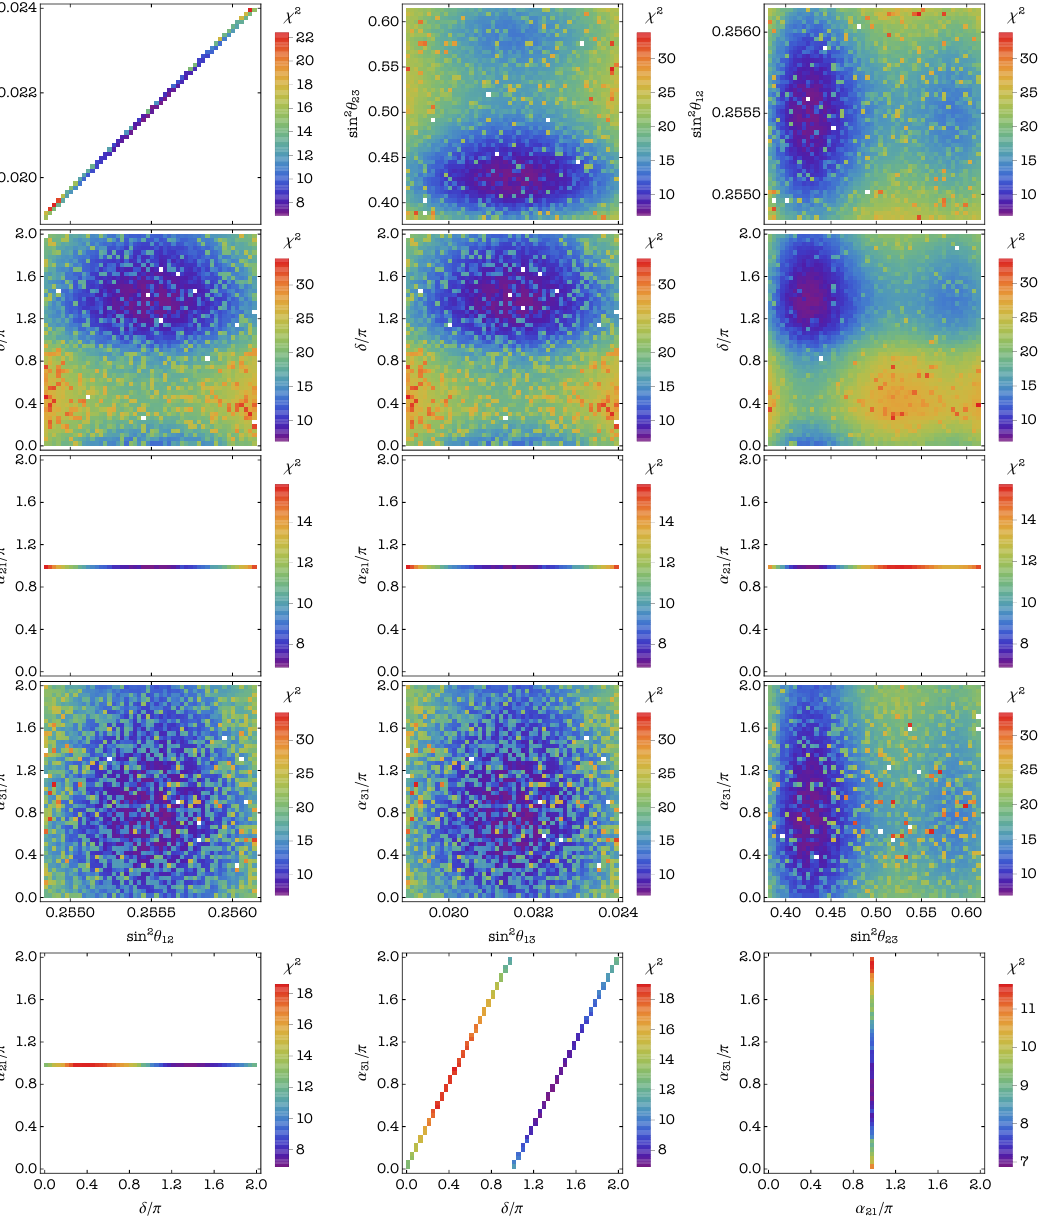
Figure 5 . Correlations between the neutrino mixing parameters in case C1. The values of all the three mixing angles are required to lie in their respective 3 (cid:27) ranges. Colour represents values of (cid:31) 2 for the NO neutrino mass spectrum. Note that this case is not compatible with the 2 (cid:27) range of sin 2 (cid:18) 12